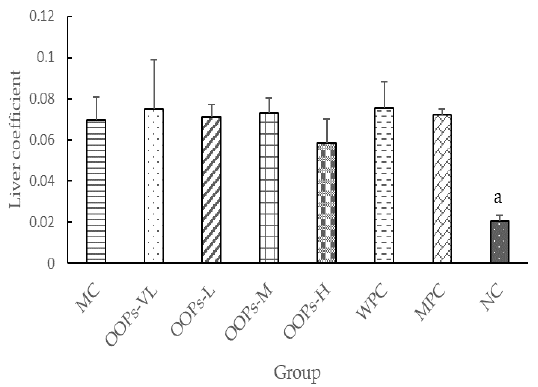
Figure 4. Effect of OOPs treatment on the liver coefficient. Values are expressed as the means ± SD of eight rats in each group. a p < 0.05 versus MC group.